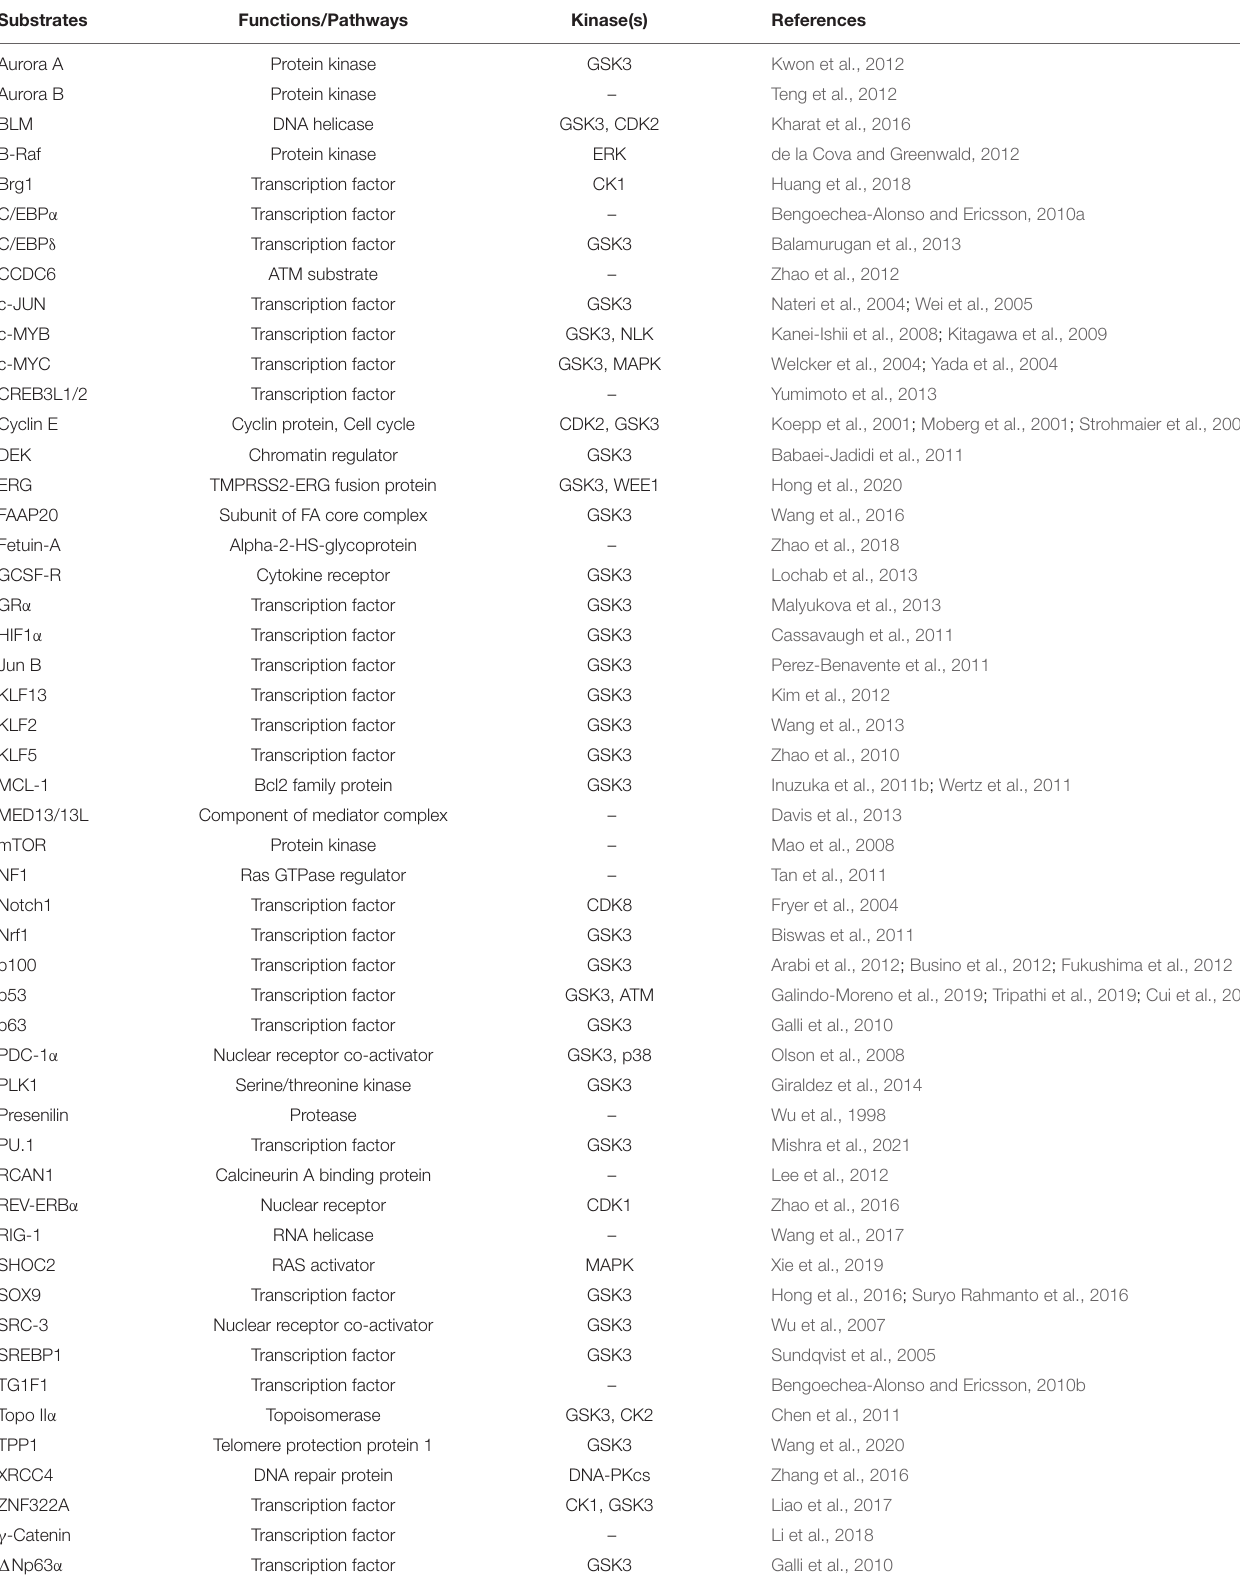
TABLE 1 | Summary of FBXW7